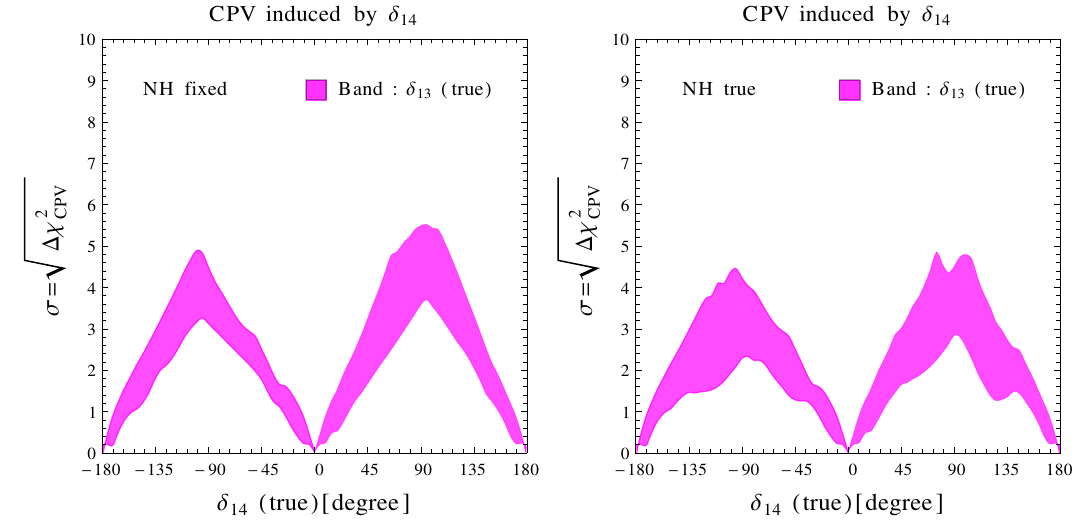
Figure 5 . Discovery potential of (cid:14) 14 6 = (0 ; (cid:25) ). In the left panel the MH is (cid:12)xed to be the NH. In the right panel the MH is marginalized with NH as the true choice. In both cases we have taken true and test (cid:18) 14 = (cid:18) 24 = 9 0 . The bands have been obtained by varying the true value of (cid:14) 13 in its allowed range of [ (cid:0) (cid:25); (cid:25) ] while marginalizing over its test value in the same range.